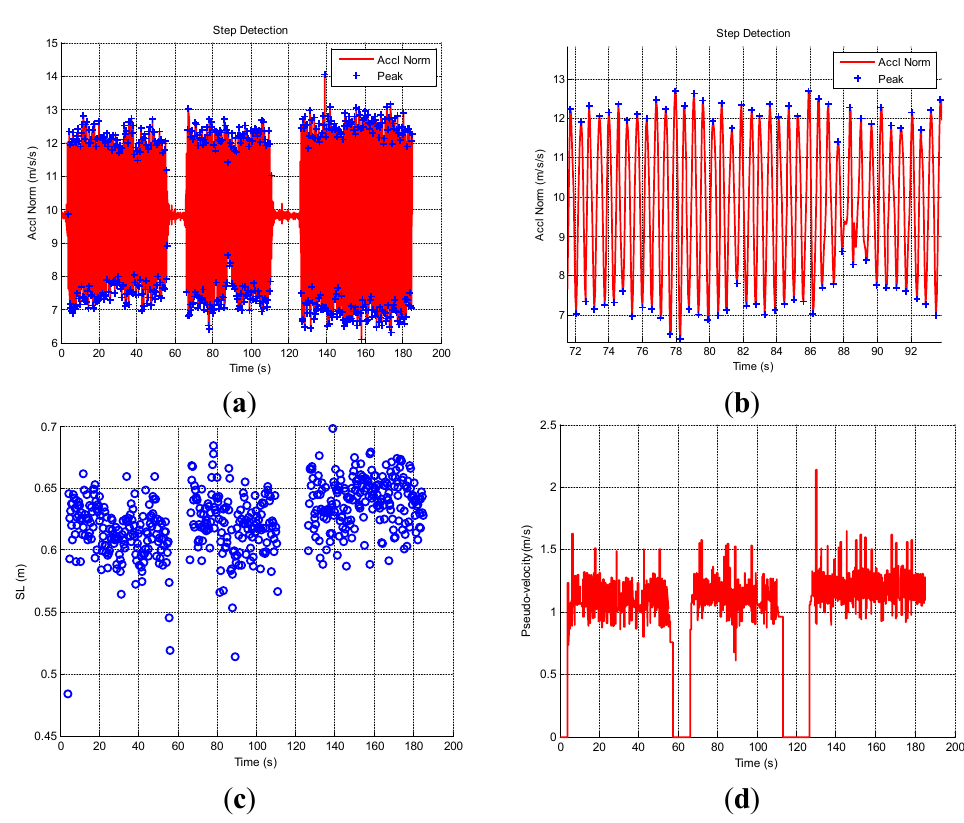
Figure 6. Results of the step detection and step length estimation. ( a ) Step detection for the whole trajectory; ( b ) Zoom-in of some parts of step detection for the trajectory; ( c ) Result of step length estimation; ( d ) Result of pseudo-velocity from step